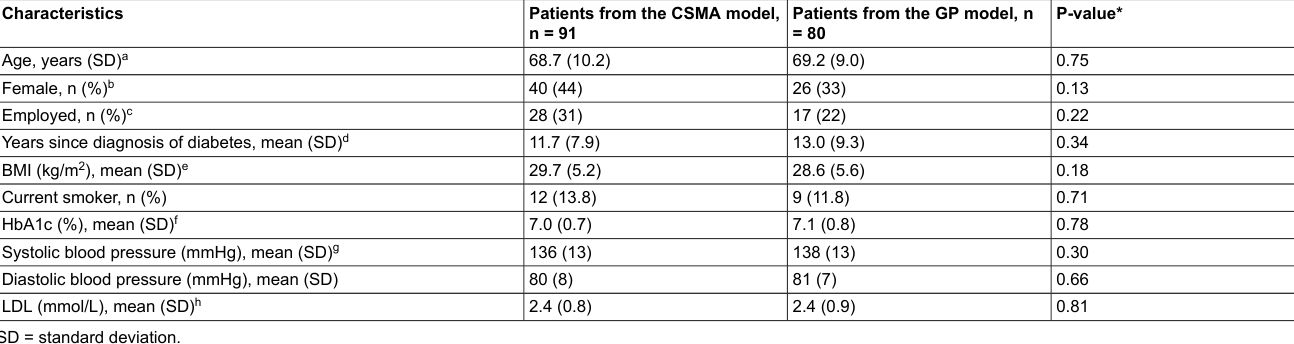
Table 2: Characteristics of patients.